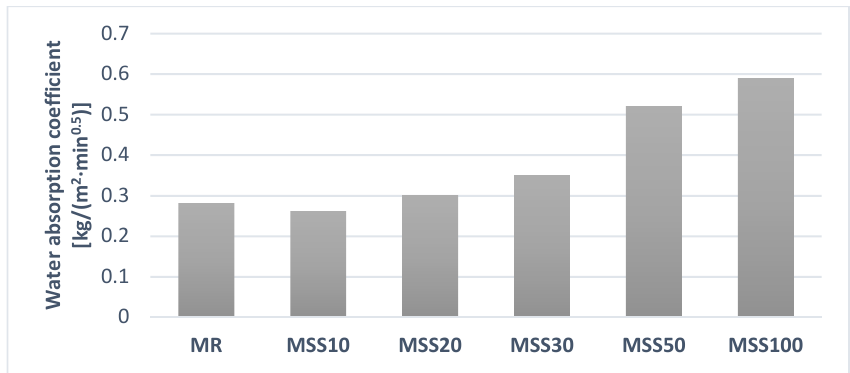
Figure 15. Specimen during the determination of water absorption coefficient due to capillary ac- tion.